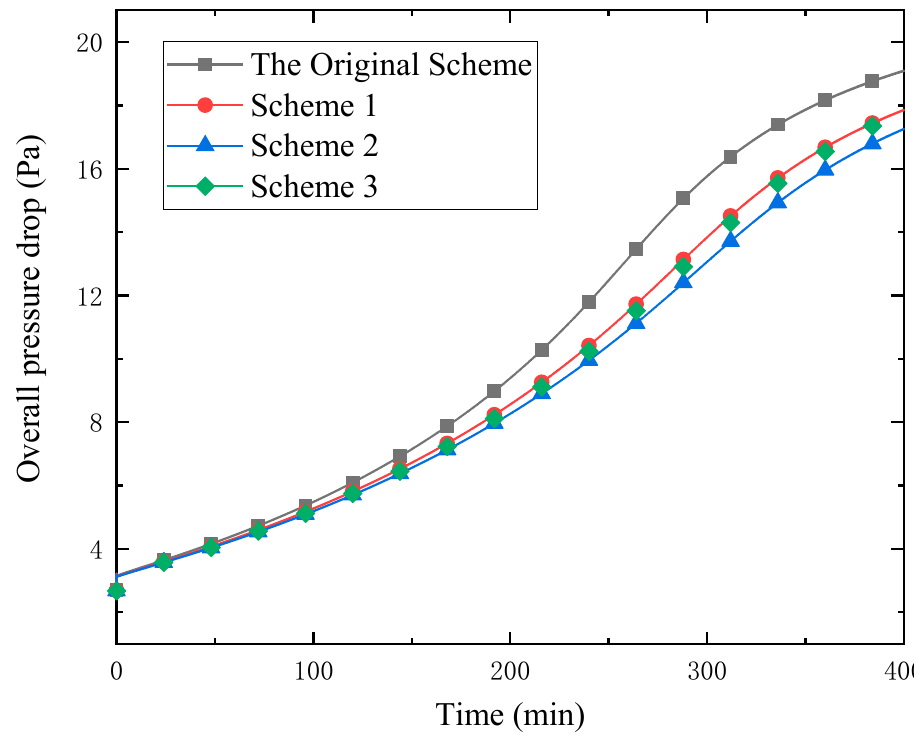
Figure 8. Overall pressure drop for three schemes during frosting 400 min duration.